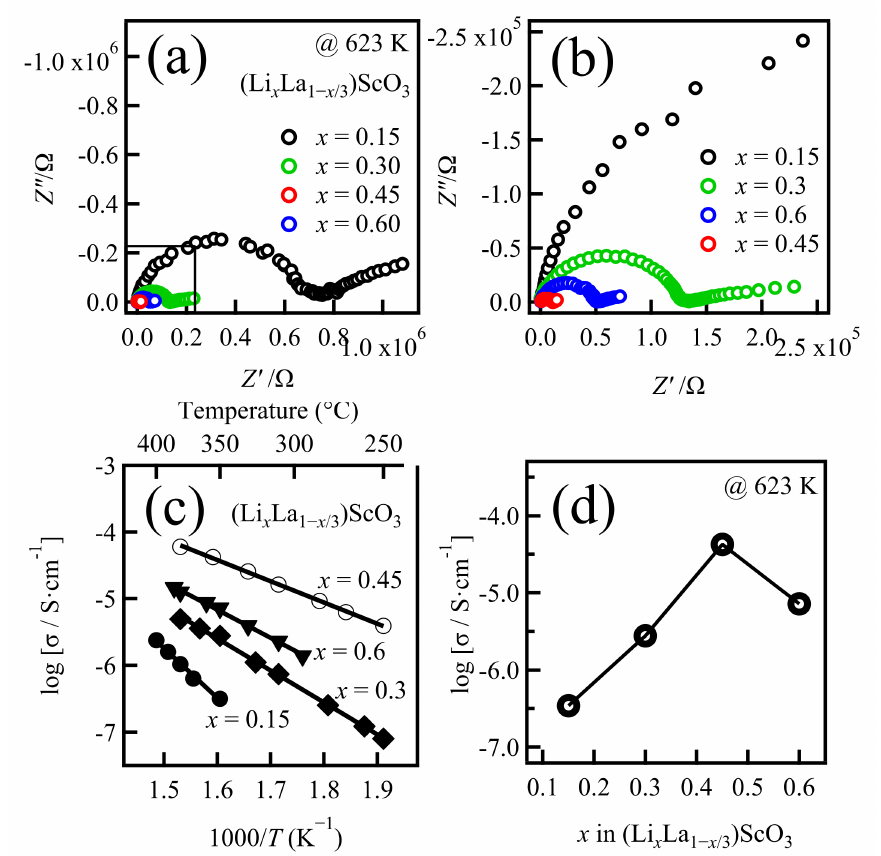
Figure 2. ( a , b ) Impedance plots obtained at 623 K, ( c ) temperature dependence of the conductivity, and ( d ) variation in the conductivity at 623 K based on the composition of (Li x La 1 − x /3 )ScO 3 ( x = 0.15, 0.30, 0.45,